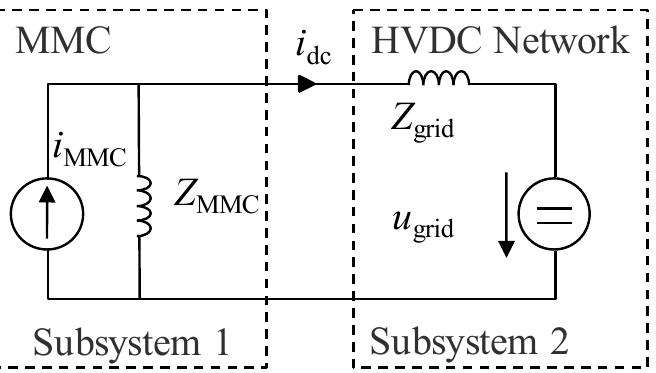
Figure 1. Impedance based stability criterion.